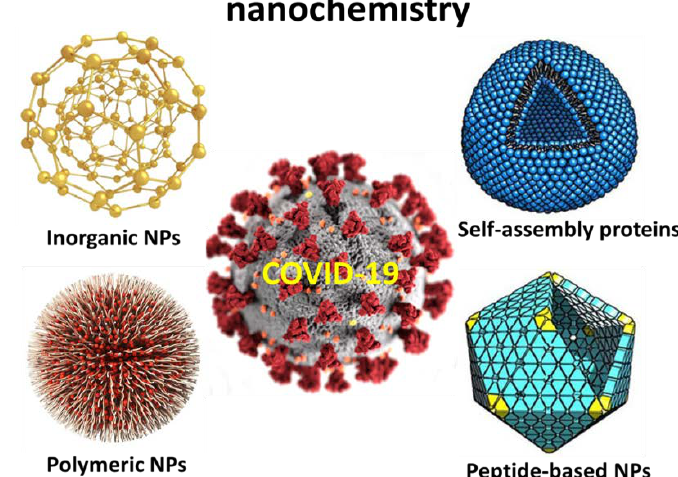
Figure 3. Applications of nanoscience to face Figure 3 . Applications of nanoscience to face COVID-19.